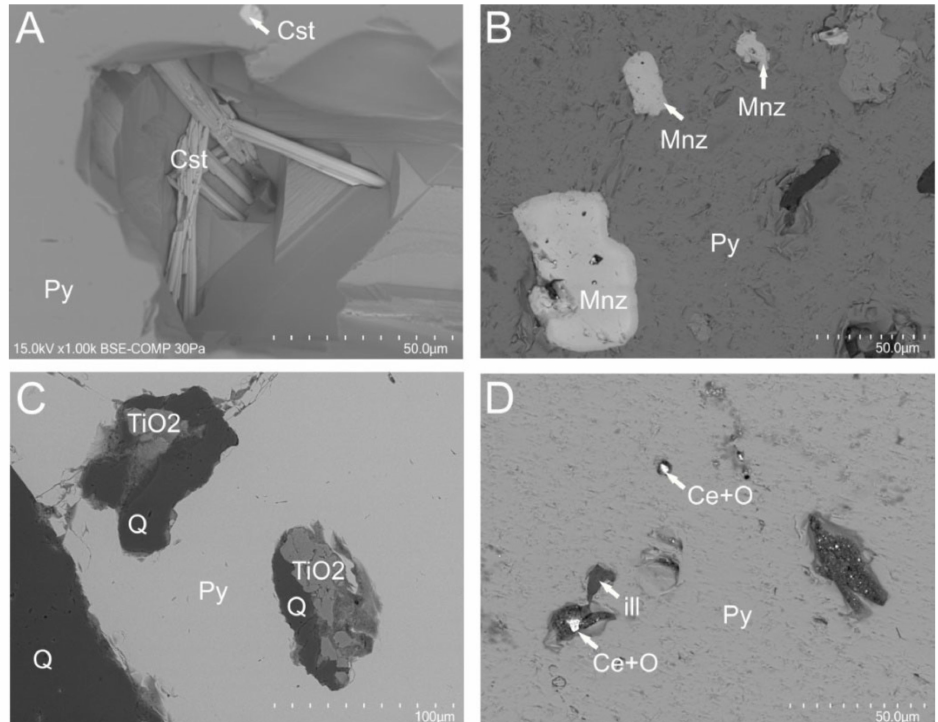
Figure 5. ( A – D ) SEM back-scattered images of Py-III (quartz veins, with molybdenite and scheelite). ( A ) cassiterite inclusion trapped by pyrite due to its faster growth, ( B ) monazite inclusions in Py-III, ( C ) Inclusions of TiO 2 phases in Py-III, ( D ) Inclusions of cerianite-(Ce) in Py-III. Abbreviations: Py—pyrite, Cst—cassiterite, Mnz—monazite-(Ce), TiO 2 —rutile, Q—quartz, Ce + O—cerianite-(Ce), ill—illite.